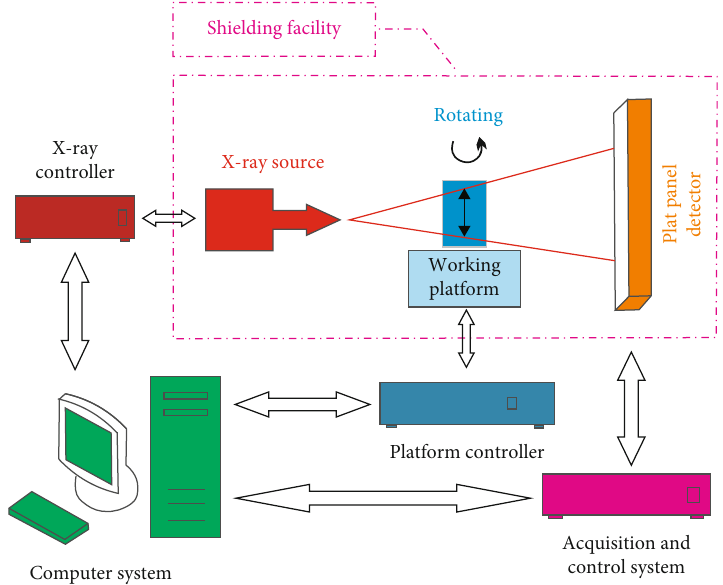
Figure 2: Schematic diagram of the industrial cone-beam X-ray system (modi fi ed after Ma